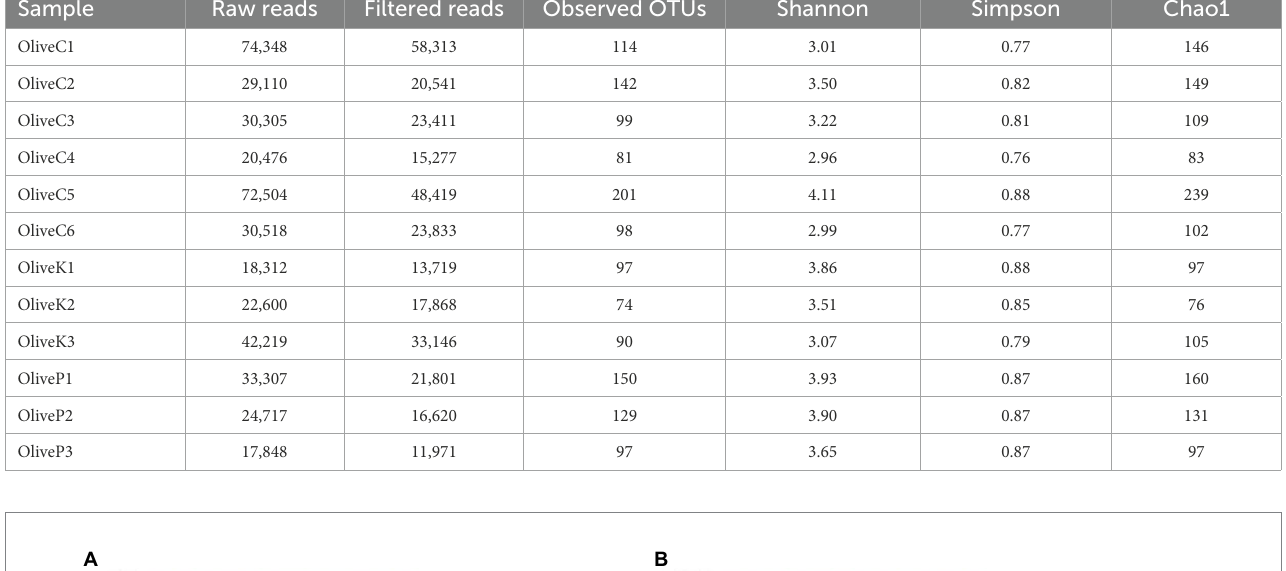
TABLE 2 Number of raw reads, filtered reads and alpha diversity indices of different olive varieties (Cypriot, Kalamata, Picual) from different regions, as revealed by 16S rRNA high throughput sequencing. Sample